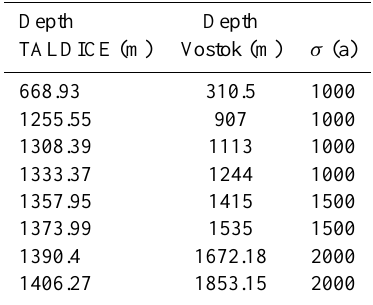
Fig. 2. TALDICE records between 0 and 250ka on TALDICE 1a age scale. Top: water stable isotope ( δ 18 O ice ) record with labeling of selected interglacial periods (Stenni et al., 2011). Middle: com- plete record of δ 18 O atm , blue triangles from Buiron et al. (2011) and red triangles from this study. Bottom: precession parameter (same as in Fig. 1). Table 2. Stratigraphic links between TALDICE and Vostok deduced from δ 18 O atm